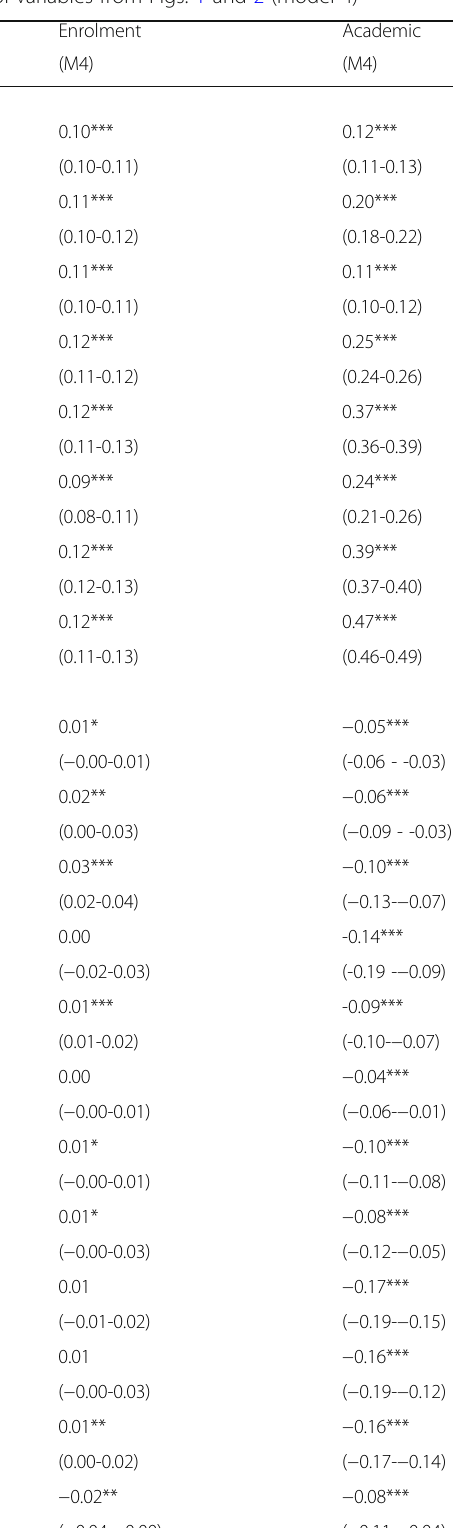
Table 1 Beta coefficients (with 95% c.i.) of control variables from Figs. 1 and 2 (model